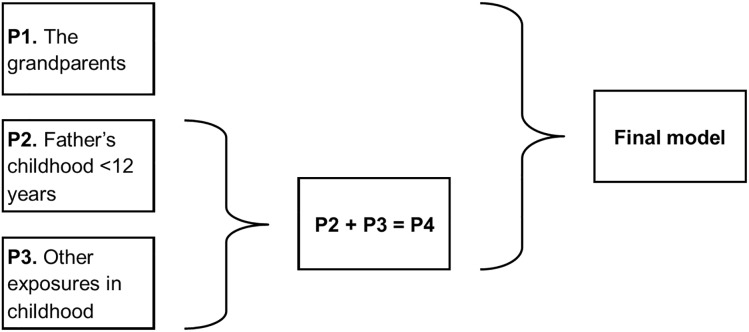
Structure of the analysis of the exposure to the paternal line.